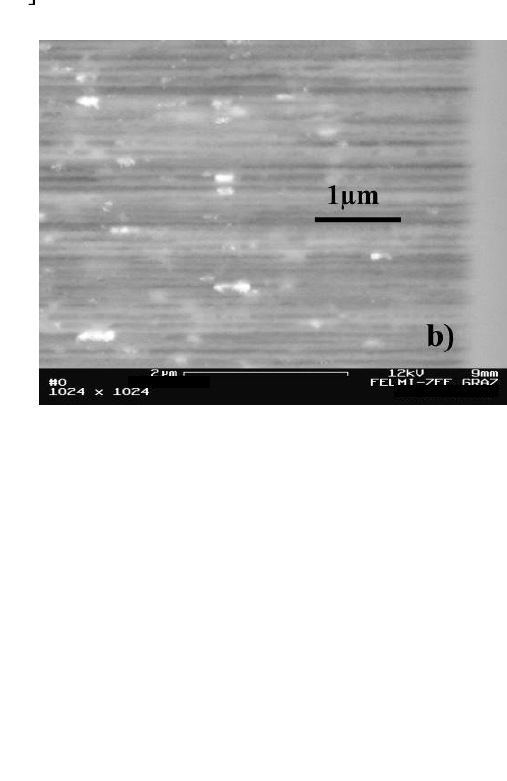
Figure 18. (a) Scanning electron micrograph using the back scattered electrons showing Ni-nanowires with an elongation of about 2.5 µm (current density = 40 mA/cm 2 , pulse duration = 5 s). (b) Ni-nanostructures deposited into a porous silicon matrix with a length of about 200 nm (current density = 40 mA/cm 2 , pulse duration = 20 s). (c) Back